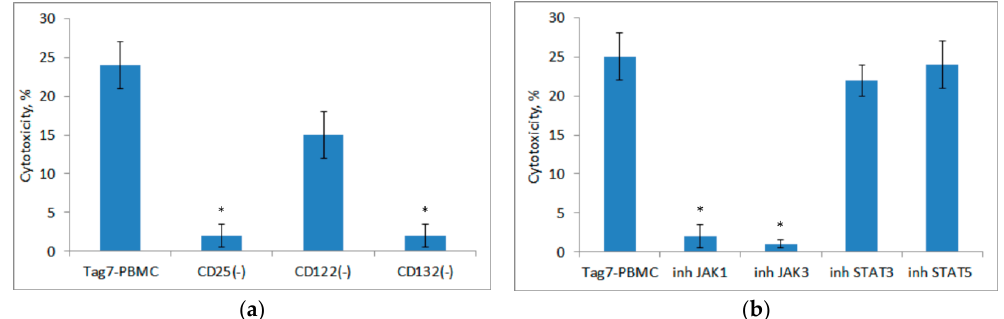
Figure 4. Role of IL-2 receptor in activating signal transmission. ( a ) Lymphocytes expressing IL-2Rα (CD25), IL-2Rβ (CD122) and IL-2Rγ (CD132) subunits were removed from PBMCs by magnetic separation, and the remaining cells were incubated with Tag7 for 6 days and tested for cytotoxicity